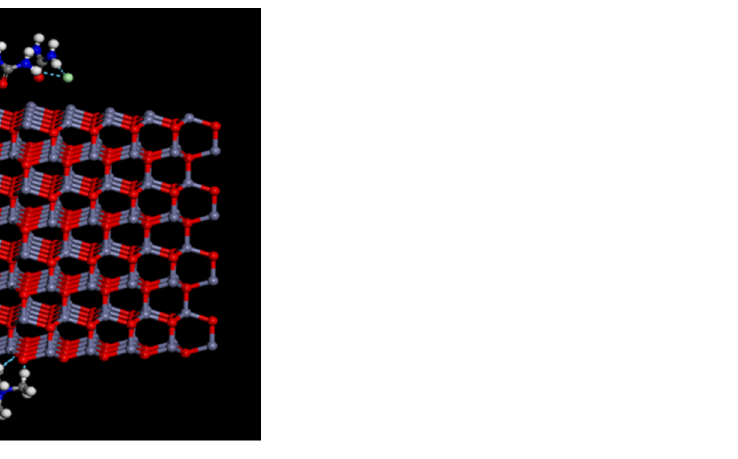
Figure 9. Molecular structure diagram of the reaction product between ZnO and the ChCl-urea DES.